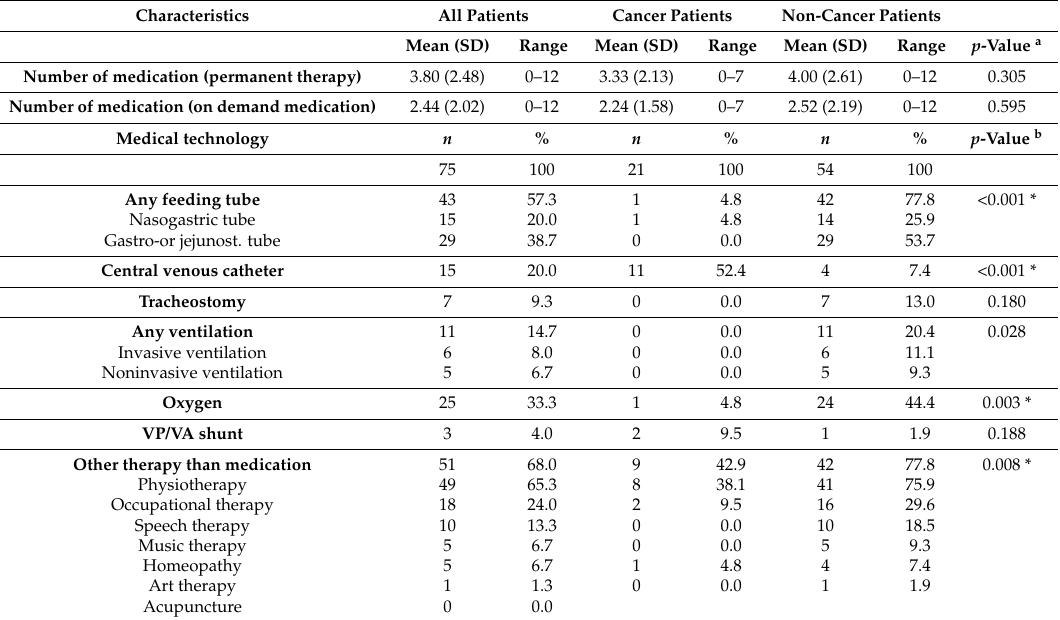
Table 5. Clinical characteristics of cancer and non-cancer